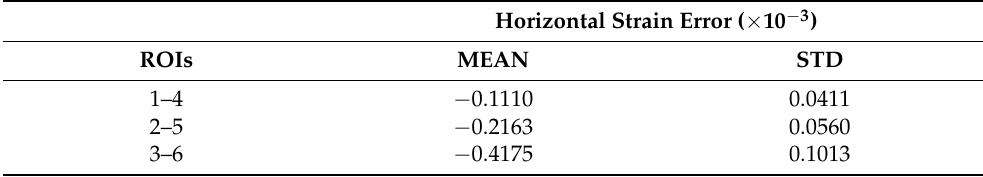
Table 1. Horizontal strain error for a long-term still sequence of the recorded images.